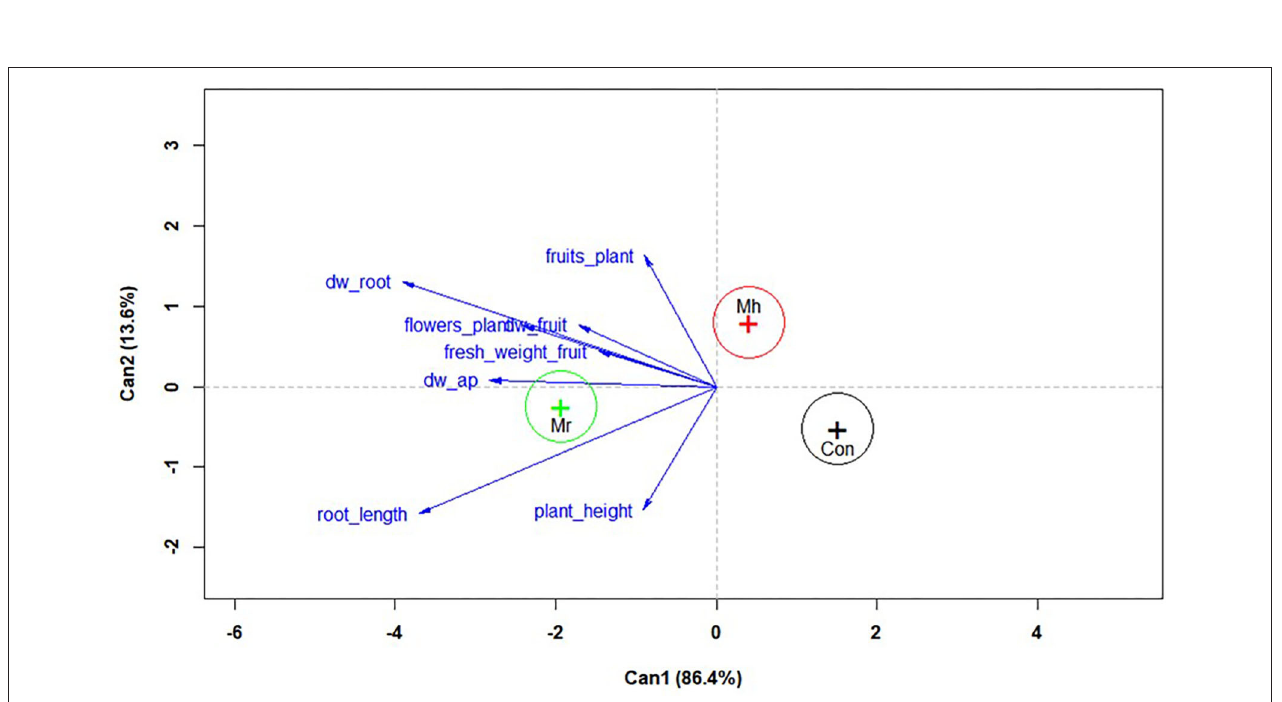
FIGURE 3 | Canonical discriminant plot showing two principal canonical components, in which the blue vectors indicate different magnitudes of correlation with both axes corresponding to plant growth traits recorded at 30 days after inoculation, while circle groups are attributed to fungal species and fungus-free control. (Mr, M. robertsii; Mh, M. humberi; Cont, control). Each fungal species was represented by n = 60 observations. Vector legends: dw_ap, shoot (aerial part) dry weight; dw_root, root dry weight; dw_fruit, fruit dry weight.